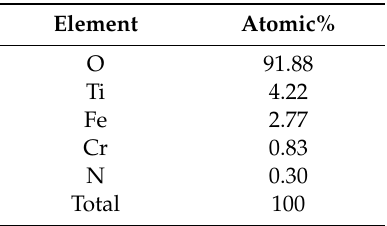
Figure 11. EDX elemental mappings of the TiO 2 / 1000 ◦ C annealed SUS 304 interface at the rebound Figure 12 region, R: ( a ) oxygen; ( b ) titanium; ( c ) chromium; ( d ) ferum. Table 4. Chemical composition analysis by EDS for the interface at the bonded region, B of TiO 2 / 1000 ◦ C annealed SUS